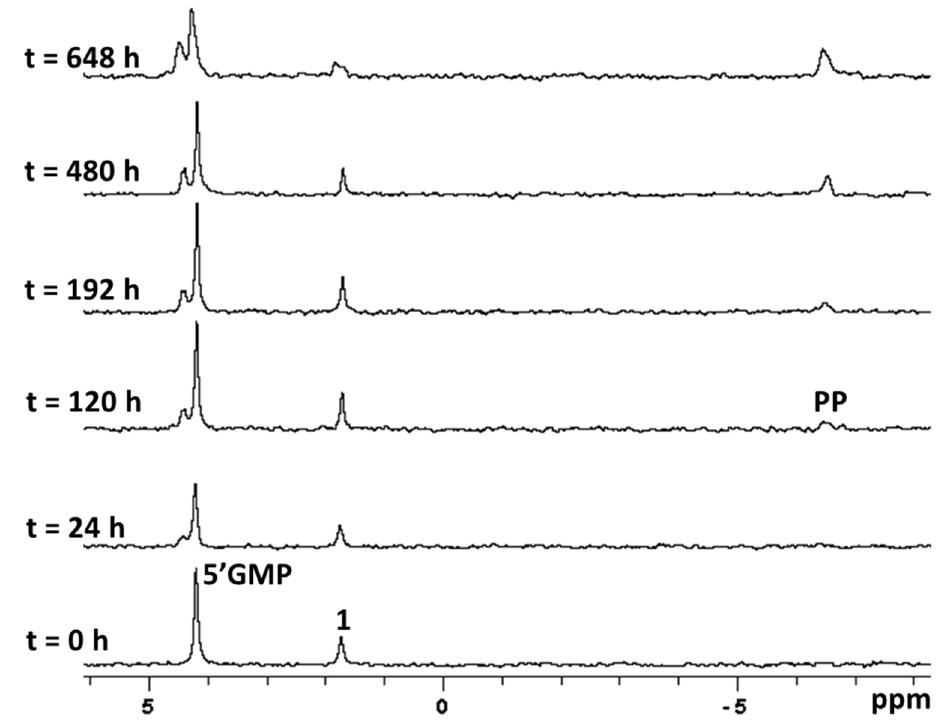
Figure 8. 31 P NMR spectra at different time intervals of 1 (5 mM) in the presence of 5’-GMP (12.5 mM) at pH* = 7.4 (D 2 O, 50 mM HEPES buffer, 120 mM NaCl, 37 °C).